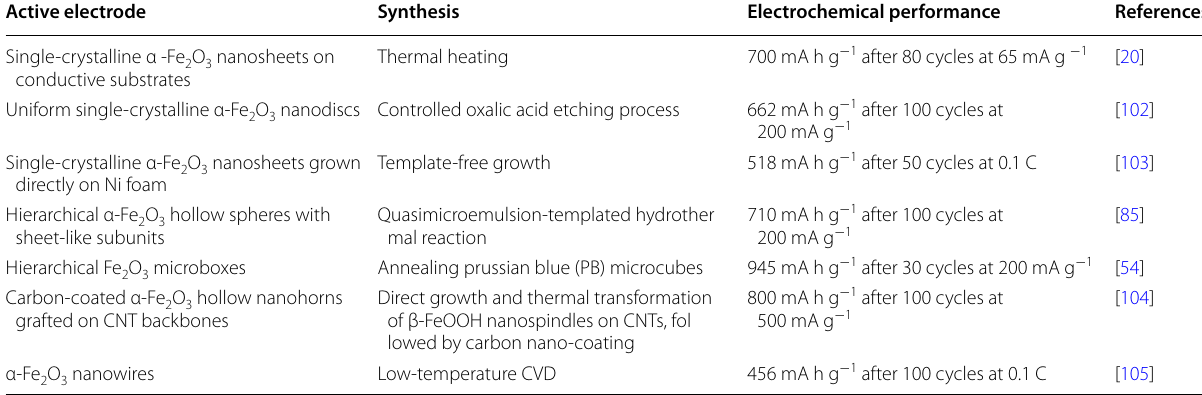
O based nanostructures 2 3